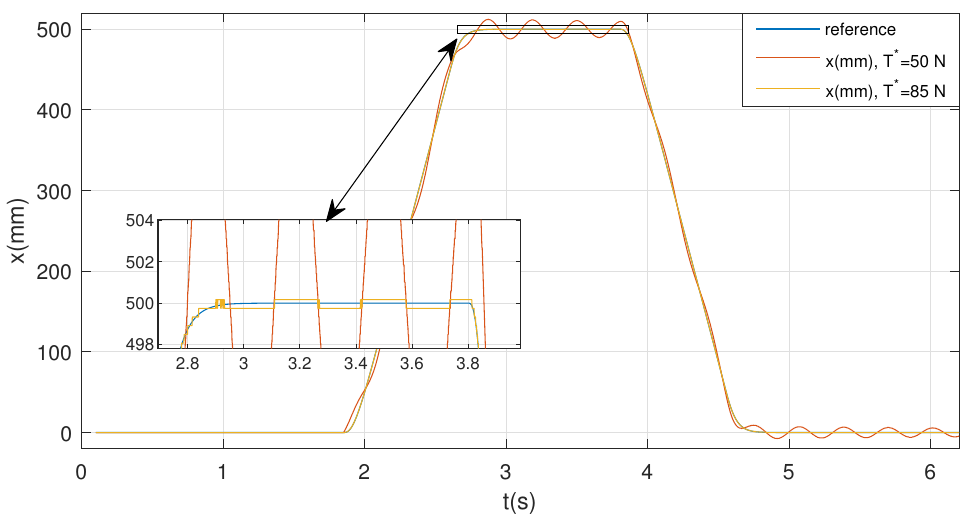
Figure 15. Trajectory tracking of horizontal manoeuvres with different values of T ∗